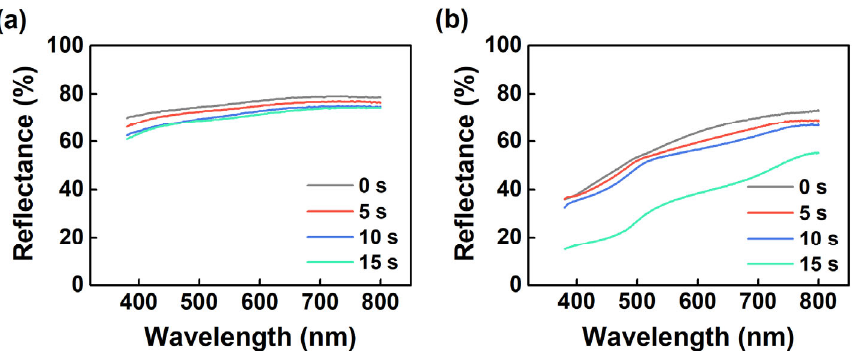
Figure 3. Reflectance spectra of the ( a ) Cr/Al/Cr/TiN and ( b ) Cr/Al/Cr/Mo anodes under the ultrasonic treatment for a different time. Table 1. The sheet resistance of the Cr/Al/Cr/TiN and Cr/Al/Cr/Mo anodes under the ultrasonic treatment for a different time.